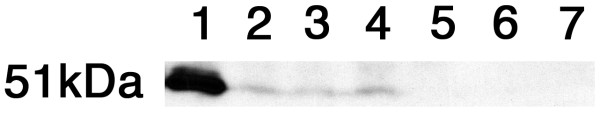
Western blot of the TRI201 enzyme from Fusarium fujikuroi (FfTRI201) extracted from VA04B-125 mashes. Mash samples weighing 1 g were collected at the end of fermentation (71 hours), and protein extractions were performed. Mashes containing untransformed RW2802 yeast were used as a negative control. For analysis, 4 μl of each extract were loaded onto a 12% acrylamide-SDS-PAGE gel and run at 150 V for 1 hour. A protein standard (Precision Plus Protein Dual Color Standard) was used to determine protein size. The western blot was probed with rabbit anti-FsTRI101 primary antibody, and the probe detected with alkaline phosphatase-conjugated anti-rabbit antibody. Lane 1: purified FfTRI201 from Escherichia coli; lane 2: FfTRI201 from mash 1 containing transformed yeast; lane 3 FfTRI201 from mash 2 containing transformed yeast; lane 4: FfTRI201 from mash 3 containing transformed yeast; lane 5: mash 1 containing untransformed RW2802; lane 6: mash 2 containing untransformed RW2802; and lane 7: mash 3 containing untransformed RW2802.